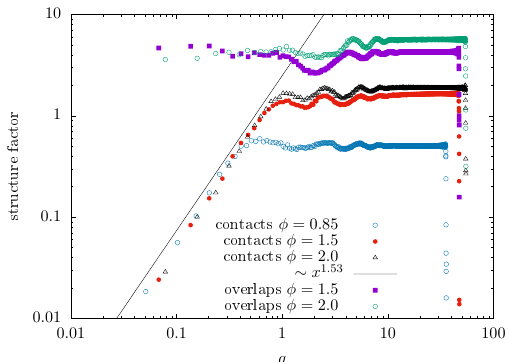
Figure 3: Structure factor of the local connectivity of the network of contacts and overlaps. For small momentum, the structure factor of the contact network decreases down to zero implying hyperuniformity in the fluctuations of connectivity. The ex- ponent controlling the behavior of the structure factor appears to be close to ∼ 1.53 which is the same found at jamming [ 21 ] . On the contrary, the connectivity of the overlap network is not hyperuniform. Data produced with system size N = 4096, di- mensions d = 2, averaged over 44 samples for φ = 0.85, over 50 samples for φ = 1.5 and 48 samples for φ =